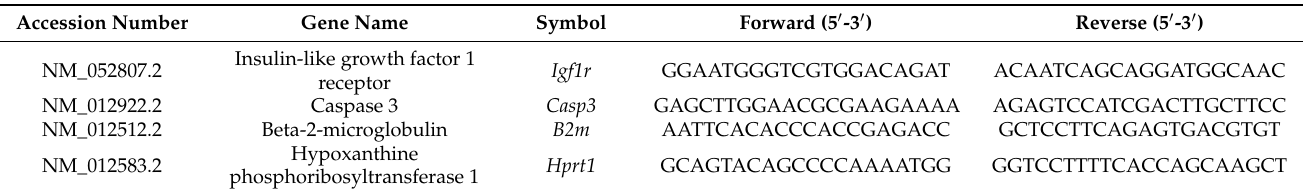
Table 3. Primer sequences for Igf1r, Casp3, B2m and Hprt